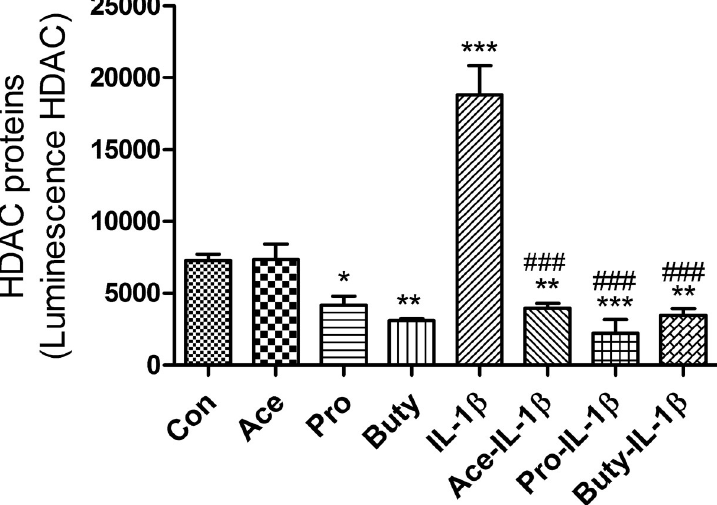
Fig 5. SCFAs inhibit IL-1 β induced HDAC protein expression in immature enterocytes. H4 cells were pretreated with 20 mM of SCFAs for 30 min before IL-1 β stimulation (1ng/ml) for 24h. Total HDACs protein (including HDAC3 and HDAC5) level was determined by Luminescent assay (using HDAC-Glo ™ I/II Assay kit). Data are represented as the mean ± SEM of two independent experiments. One -way ANOVA and Tukey post hoc tests were used for statistic, n = 3. Differences comparison to the control group were considered significant at �� p < 0.01, ��� p < 0.001; differences comparison to the IL-1 β group were considered significant at ### p < 0.001.